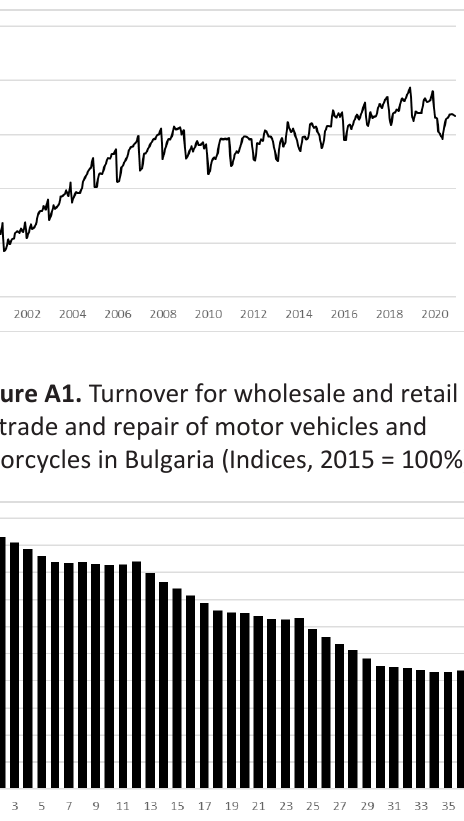
Figure A4. Turnover for wholesale and retail trade and repair of motor vehicles and motorcycles in Bulgaria (logs, first differences)